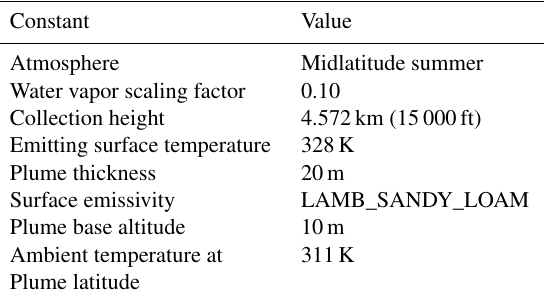
Table 3. NEdT single-pixel study MODTRAN parameter